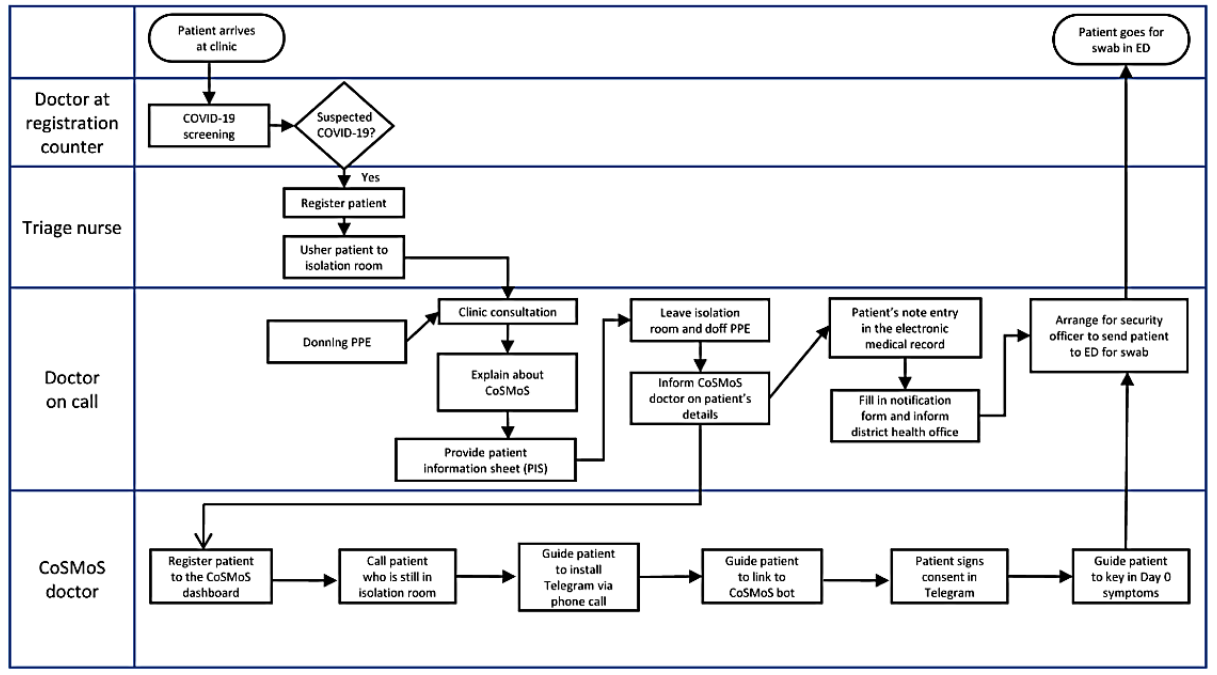
Figure 3. Integration of the COVID-19 Symptom Monitoring System (CoSMoS) into the clinical setting. ED: emergency department; PPE: personal protective